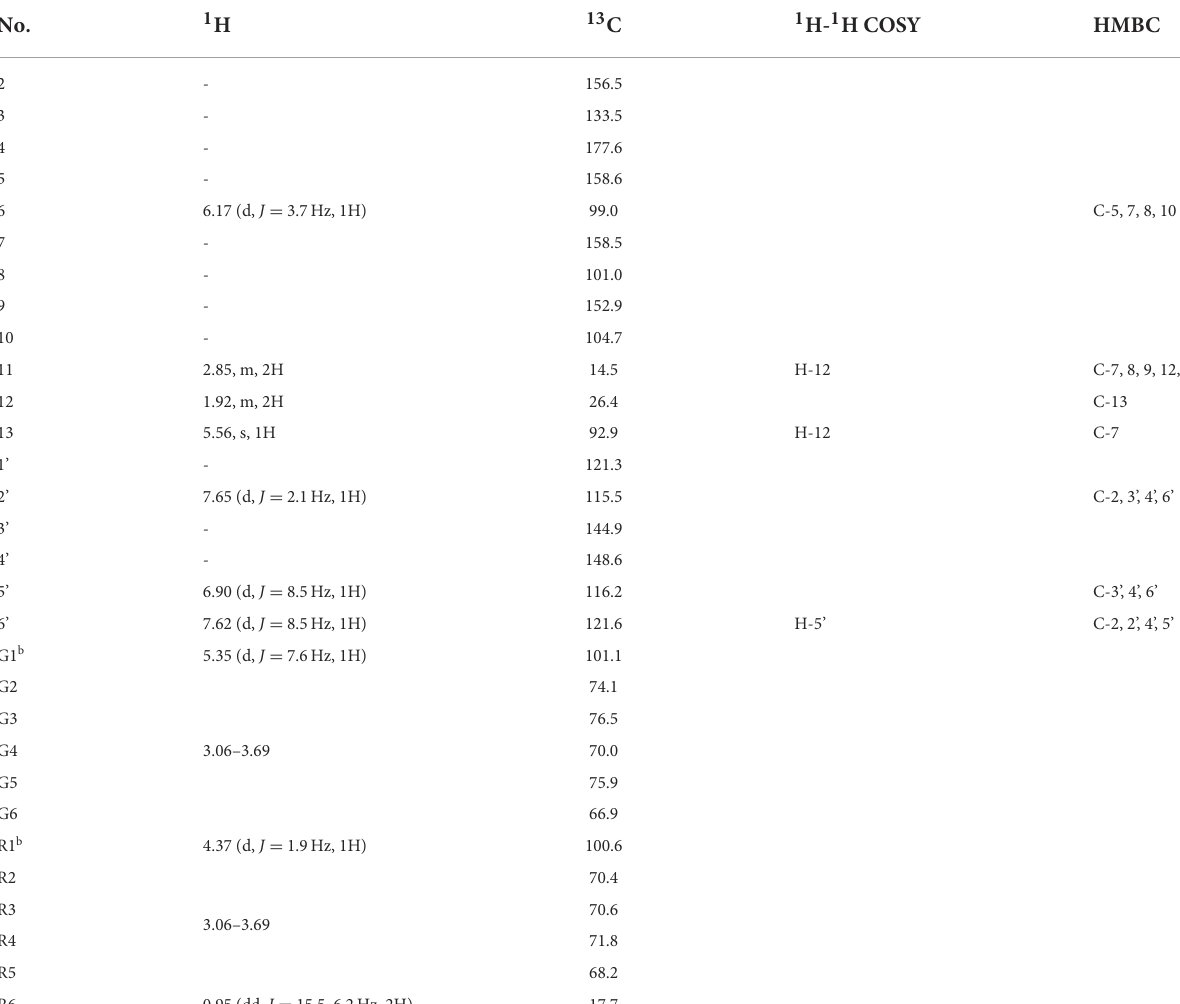
TABLE 1 The 1 H and 13 C assignments of RAC a .